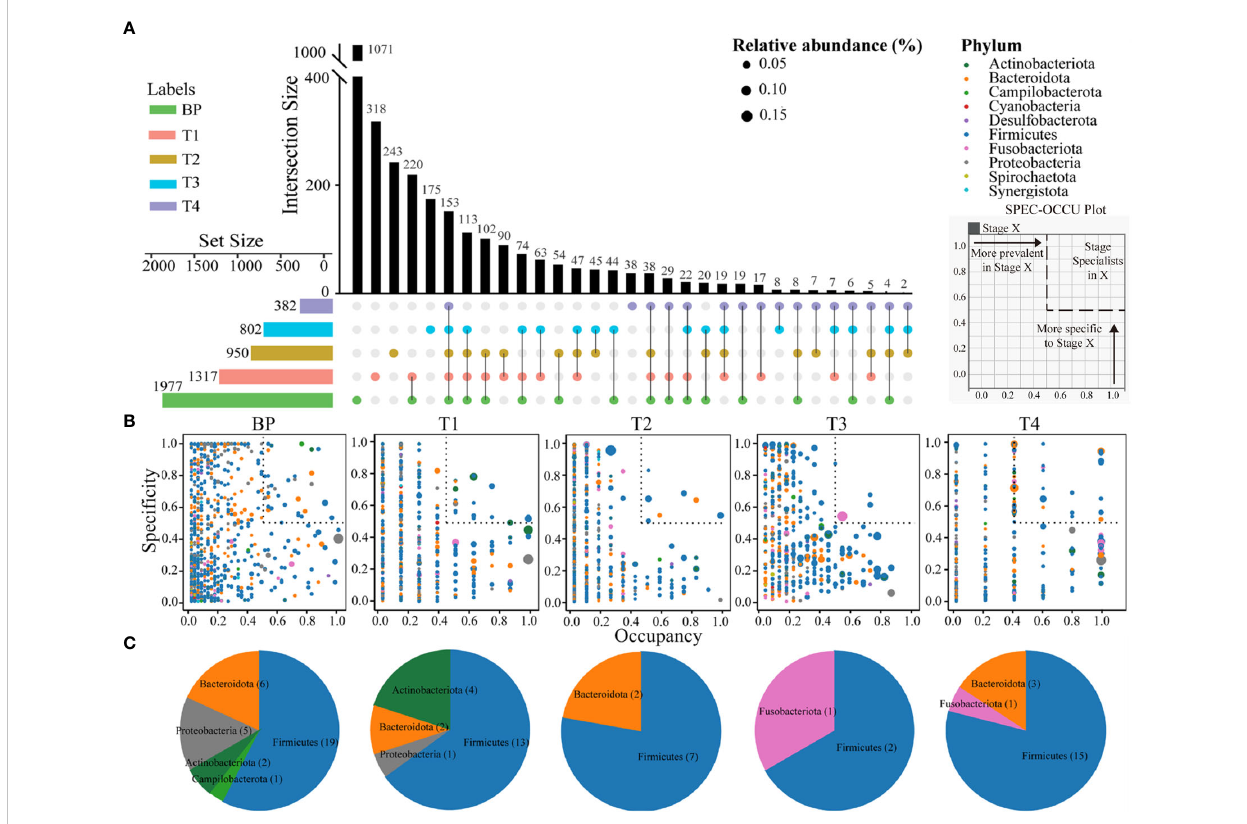
the fi ve groups (Figure S4). These results indicated an increasing distinctness in bacterial communities over CRC